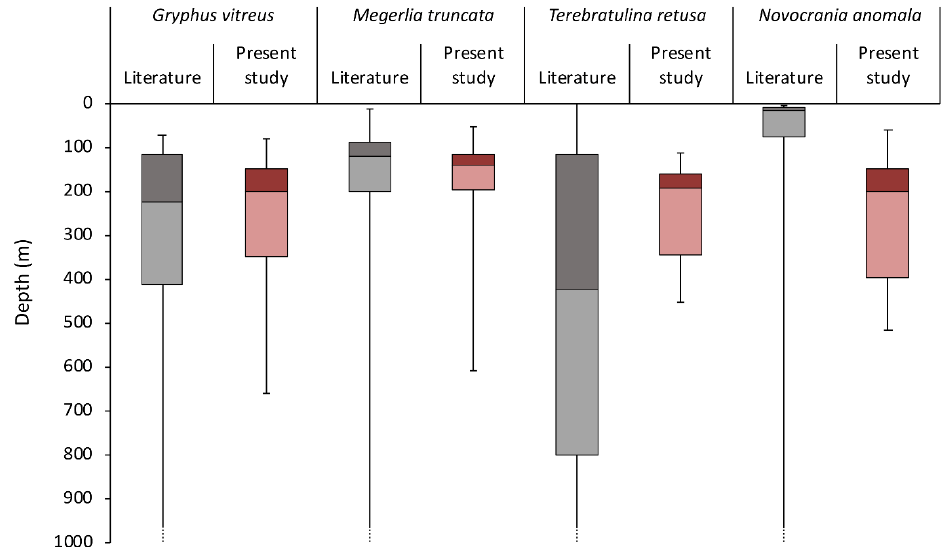
Figure 5. Comparative boxplots depicting the depth distribution of the target brachiopod species, created with data coming from literature (grey plots) and from the present study (red plots).